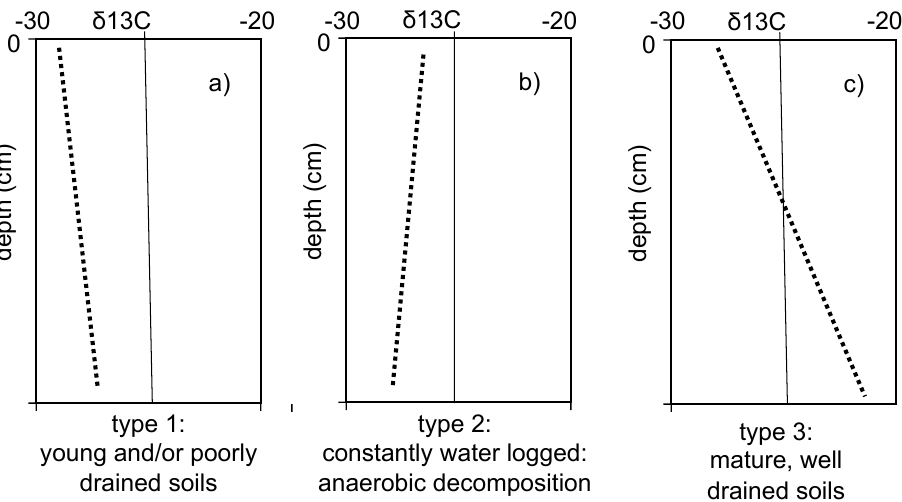
Fig. 1. Theoretical concept of isotope depth profiles in soils under regimes of differing metabolisms due to differences in water saturation and/or